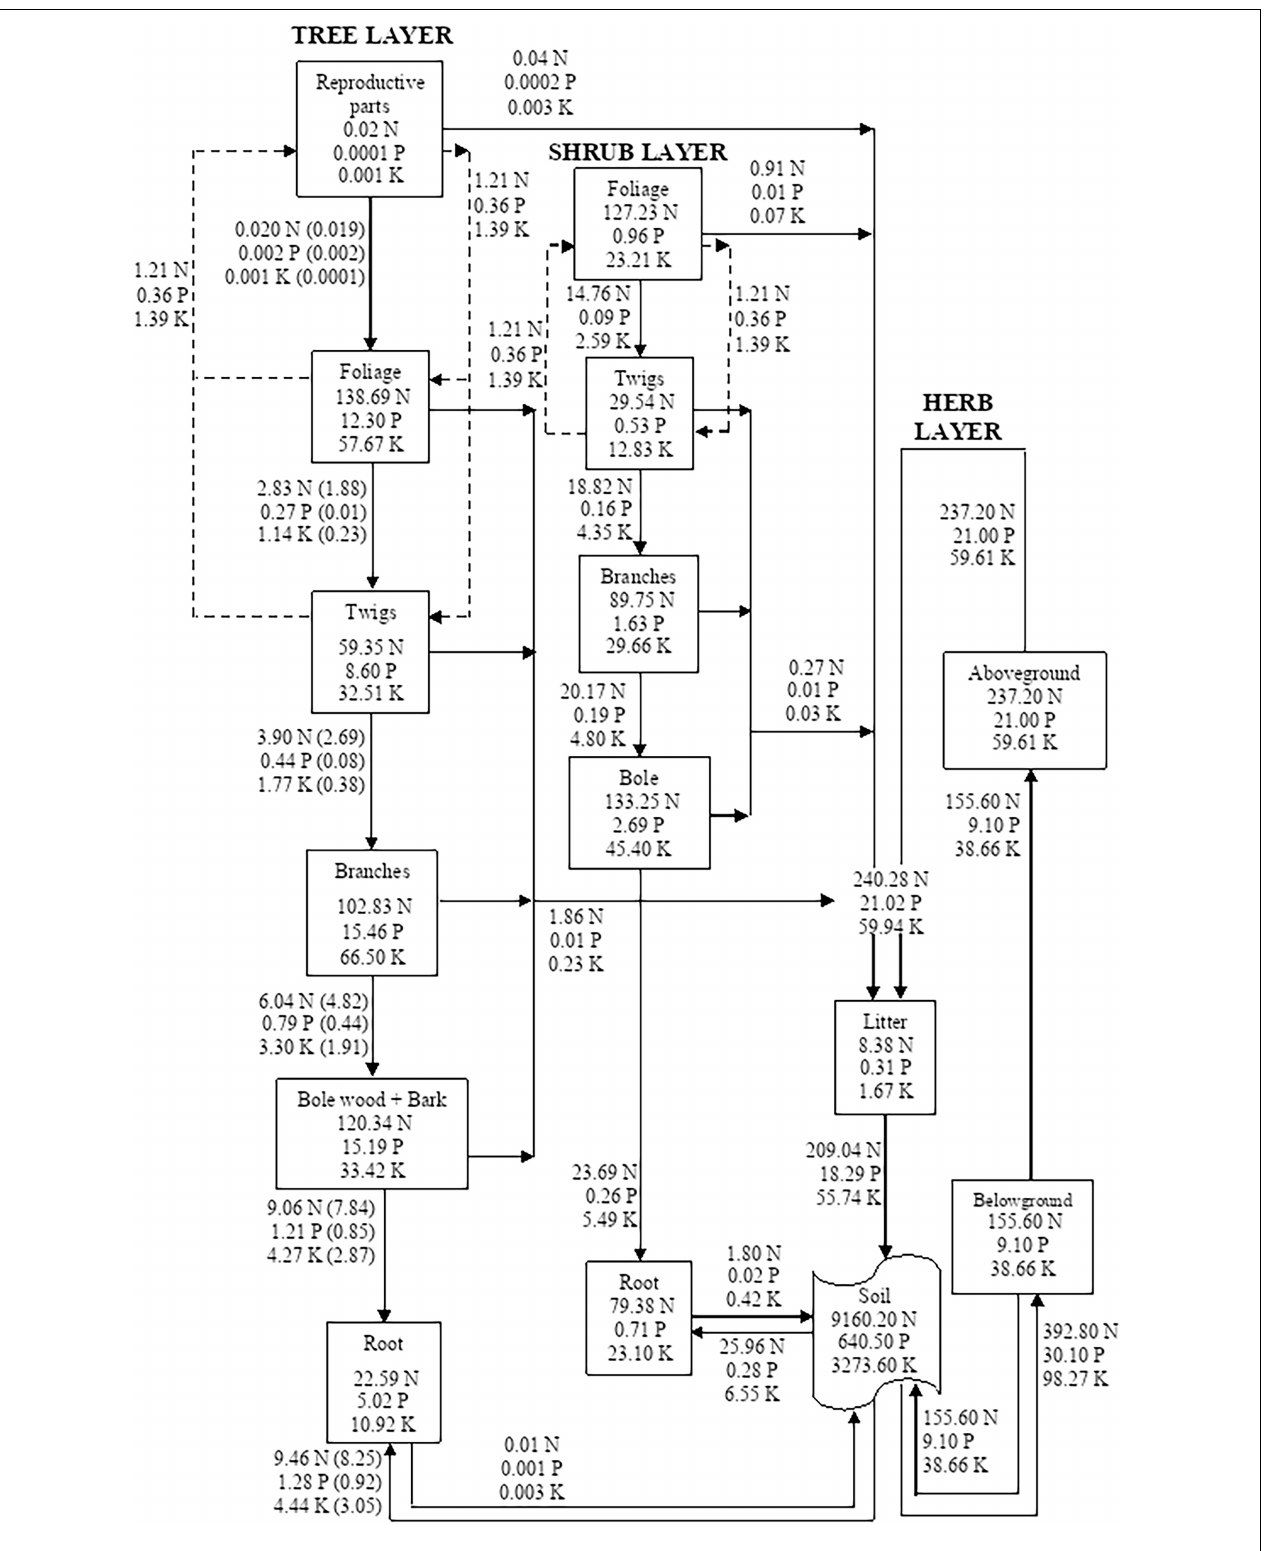
FIGURE 1 | Compartment models showing the distribution and cycling of nitrogen (N), phosphorus (P), and potassium (K) in tree, shrub, and herb at site-1. Rectangle represents a compartment for standing state of nutrients from one compartment to the next compartment. Units are kg ha − 1 yr − 1 for flows between compartments. Values in parenthesis are after adjustment for internal cycling. Recycling between reproductive parts, foliage, twigs, and bole is shown by dotted lines.